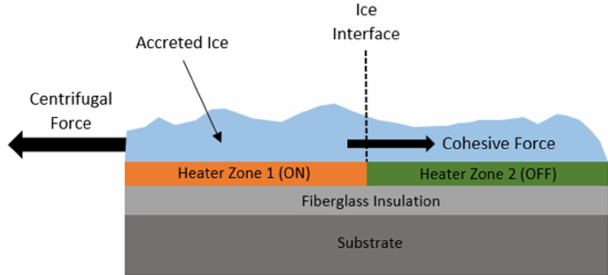
Figure 10. Schematic of cohesive force opposing the centrifugal